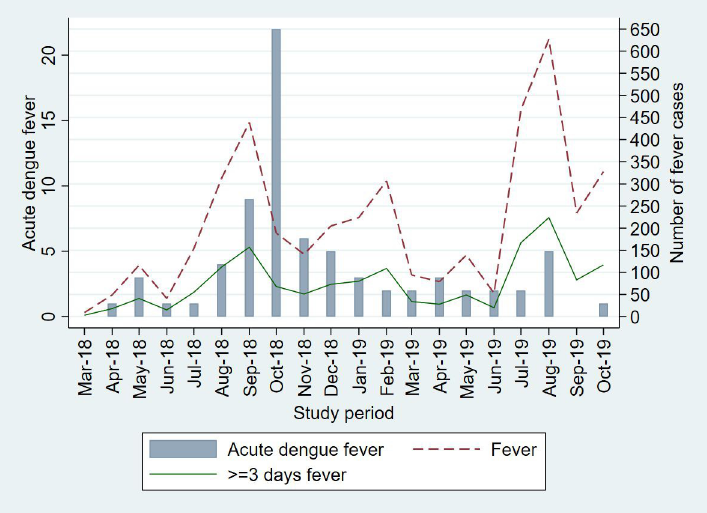
Fig 2. Acute febrile illness and dengue fever during the study period, by